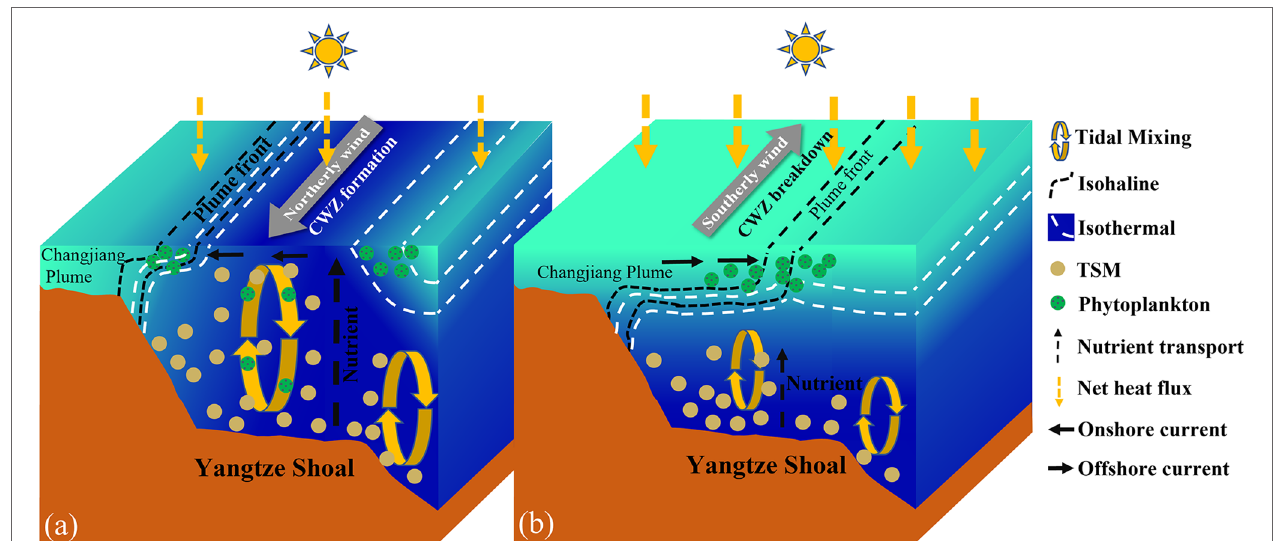
FIGURE 12 | Schematic diagram of the formation (A) and breakdown (B) mechanism of the CWZ in the YS and its effect on the phytoplankton